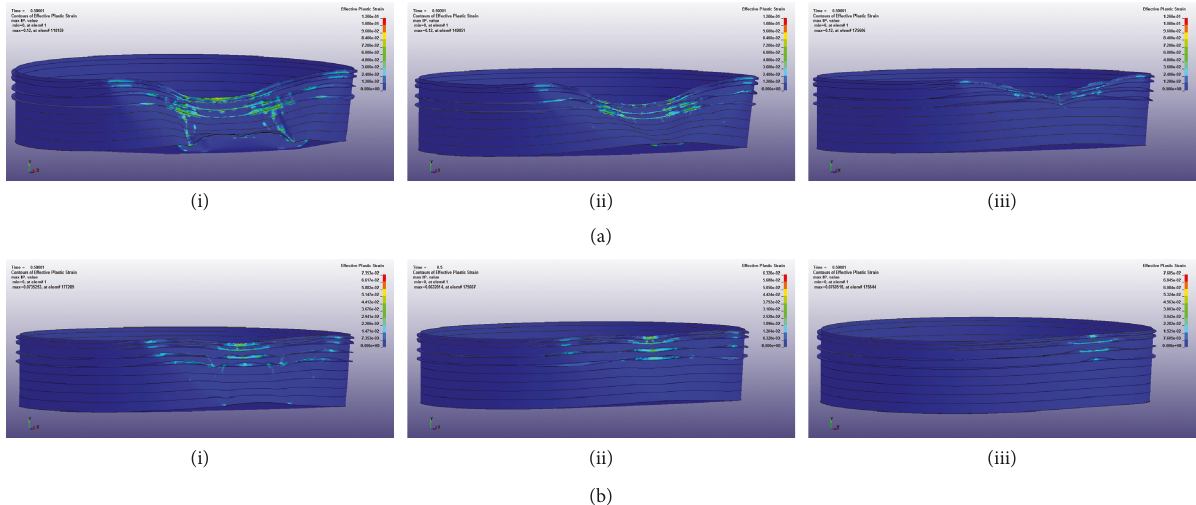
Figure 10: structure damage state in different blast intensity and fill conditions. (a) Under the blast intensity of 1500 kg TNTequivalent mass: (i) 25% fill level; (ii) 50% fill level; (iii) 75% fill level. (b) Under the blast intensity of 380 kg TNTequivalent mass: (i) 25% fill level; (ii) 50% fill level; (iii) 75% fill